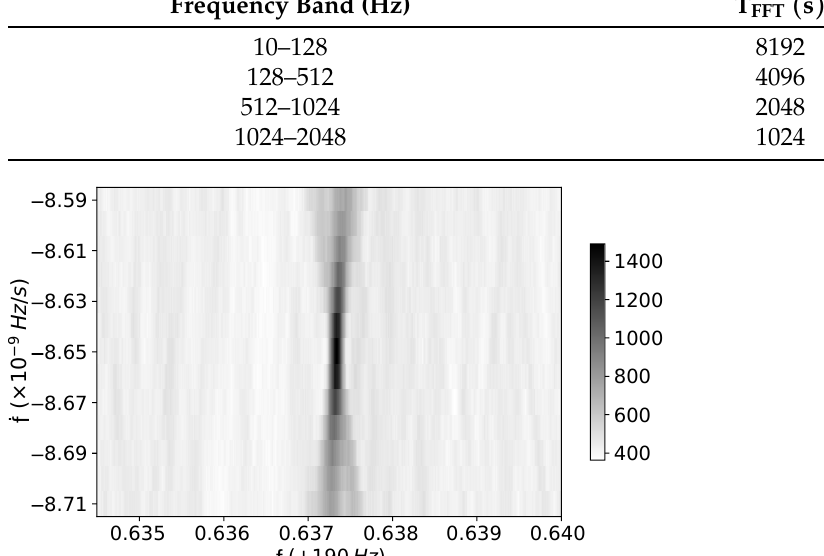
Figure 7. The GPU FrequencyHough algorithm applied to a hardware injection (so-called pulsar_8) in O2 LIGO Hanford data [27], with parameters: f 0 = 190.6373 Hz, ˙ f 0 = − 8.65 × 10 − 9 Hz/s and ecliptic coordinates λ = 351.39 ◦ , β = − 33.42 ◦ .